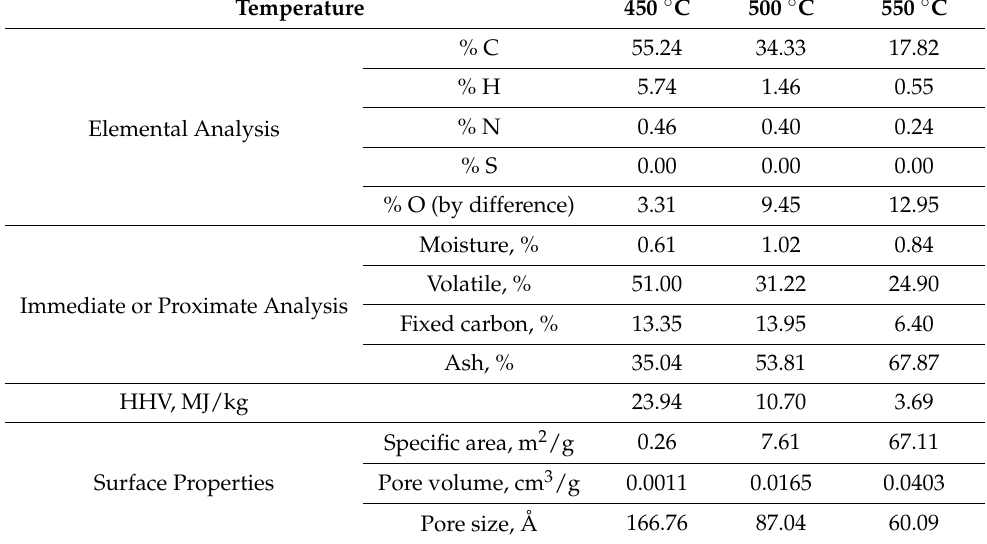
Table 4. Elemental analysis, immediate analysis, HHV and surface properties of the solids obtained by pyrolysis of the non-recyclable mixed plastics from municipal solid waste at different